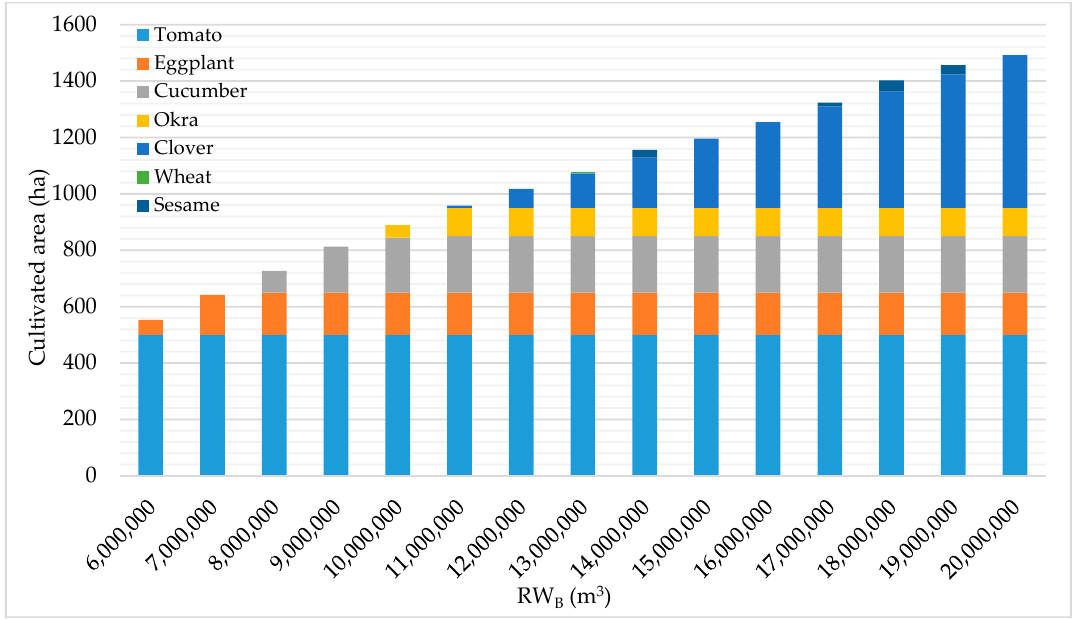
Figure 12. Predicted area (ha) of crops irrigated using reclaimed water type B (RW B ) with 65% IE.